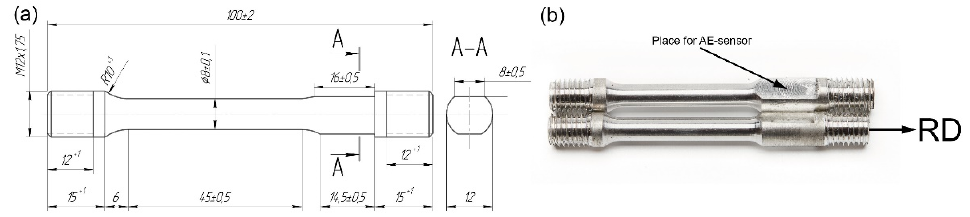
Figure 2. Schematic drawing ( a ) and photographic images ( b ) of the samples.